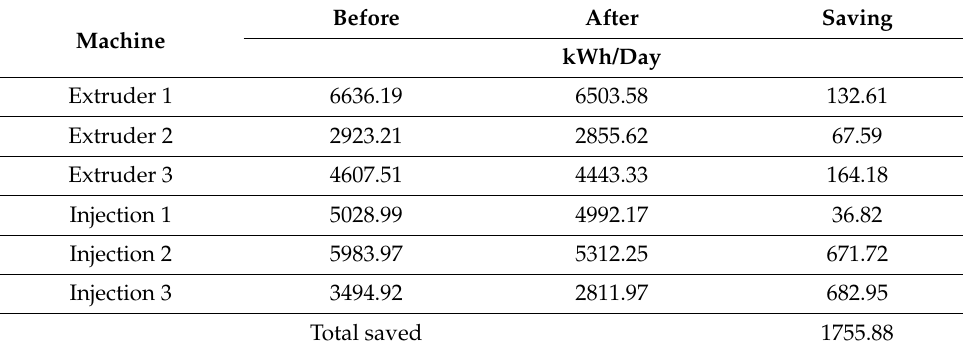
Table 9. Average electricity consumption